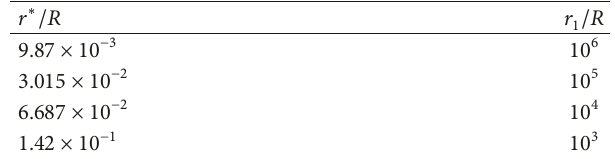
Table 1: Some values of 𝑟 ∗ /𝑅 in (15) for different values of 𝑟 1 /𝑅 . This table shows the dependence of the values of 𝑟 ∗ /𝑅 on the cutoffs 𝑟 1 /𝑅 . Ideally, we should have (𝑟 1 /𝑅) → ∞ , but since we are presenting a numerical analysis, we need to choose some large but finite value of the cutoff 𝑟 1 /𝑅 for the D3